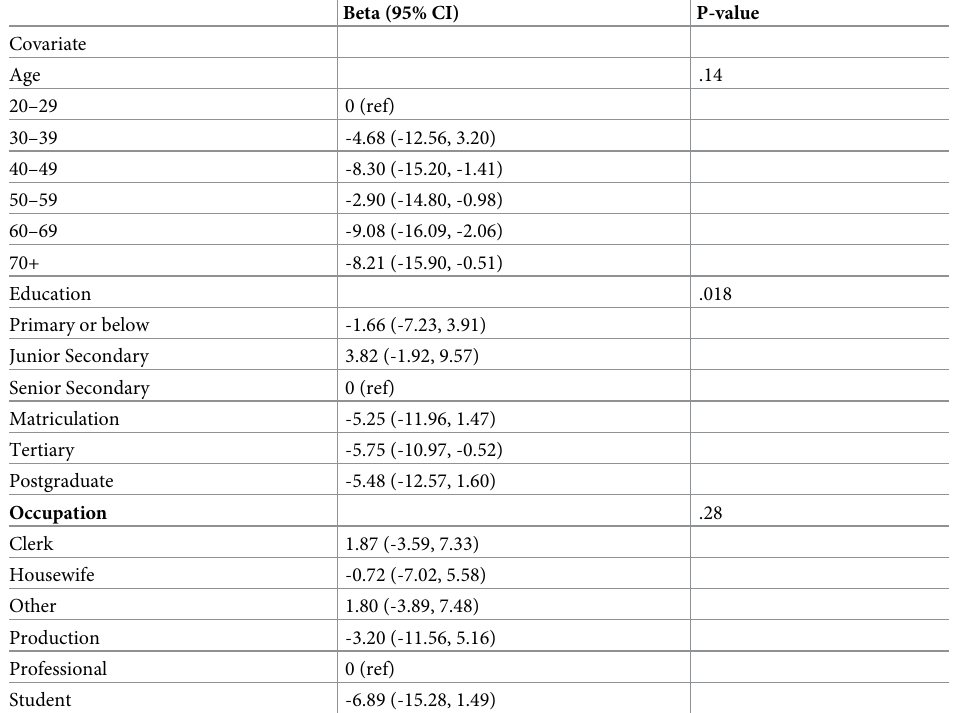
Table 4. Linear regression analysis for amount of aid supported for foreign aid for social development among those who support